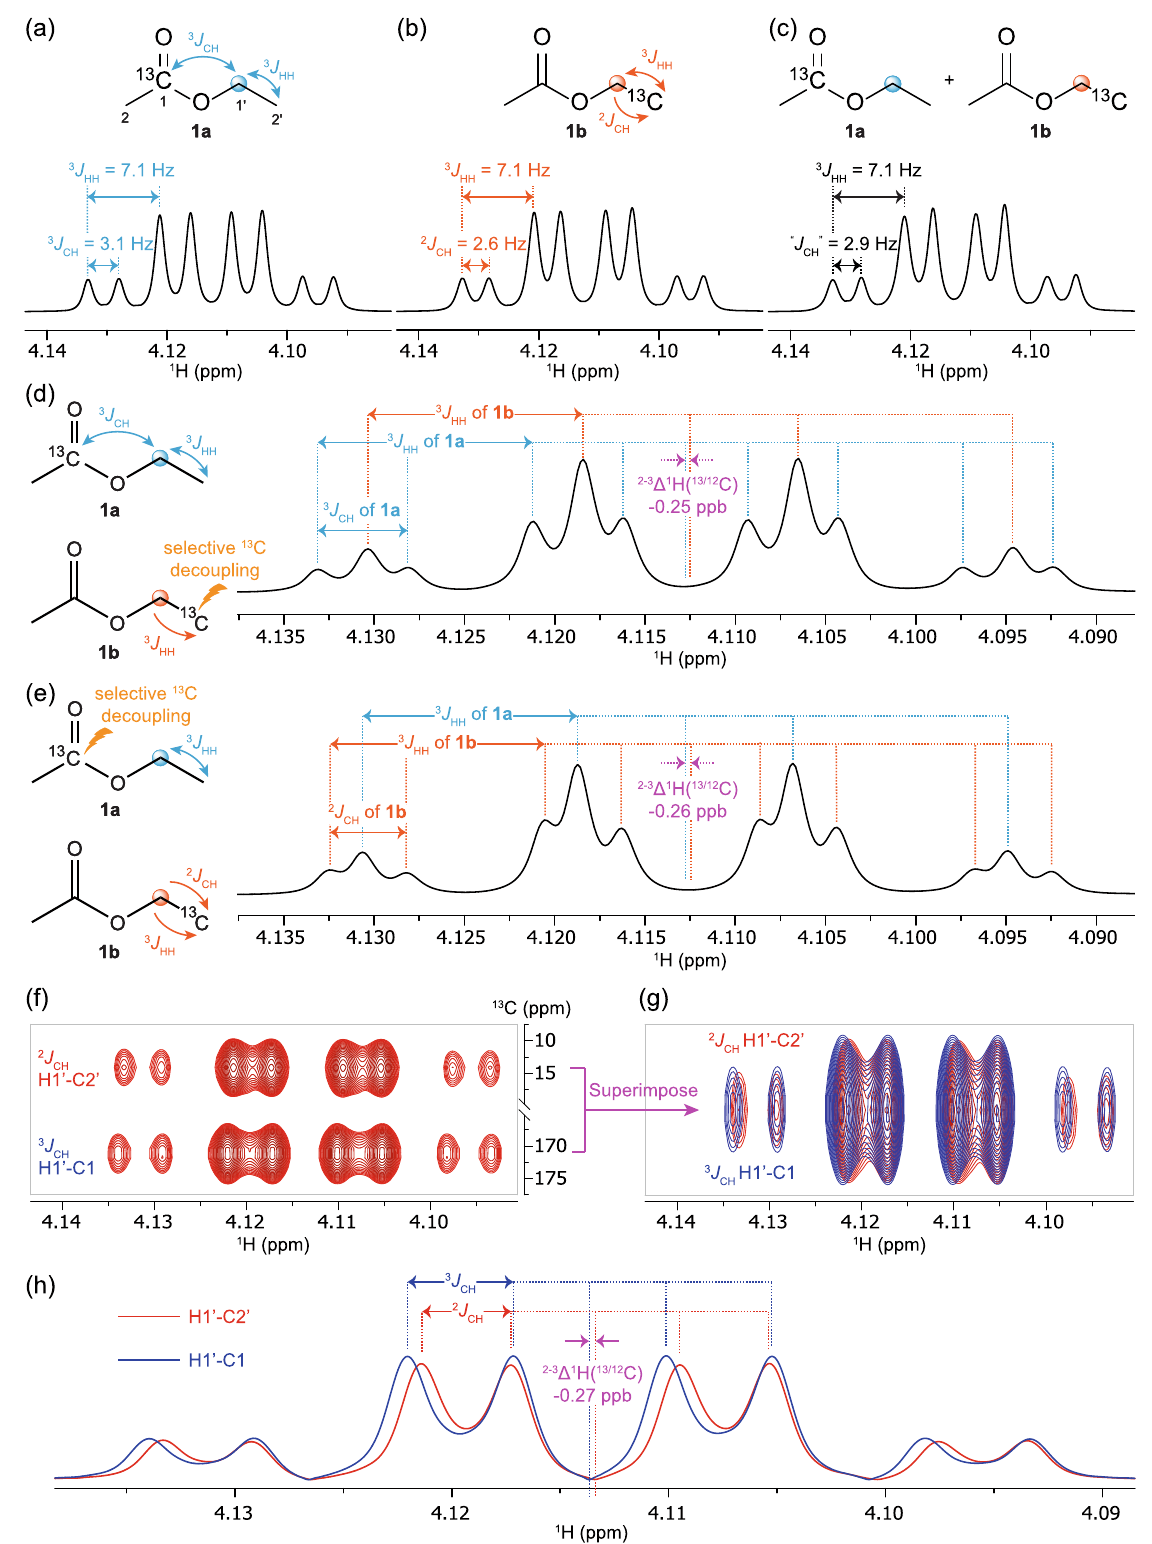
Fig. 2 | Measurements of 2-3 Δ 1 H( 13/12 C) ofEtOAc. Showing H1 ’ of ( a ) 1a (light blue), ( b ) 1b (orange),( c ) 1a + 1b ,( d ) 1a + 1b withC2 ’ selectivedecoupling,( e ) 1a + 1b with C1selectivedecoupling(isotopeshiftsaremagenta);( f )HMBCofEtOAc,zoomedin